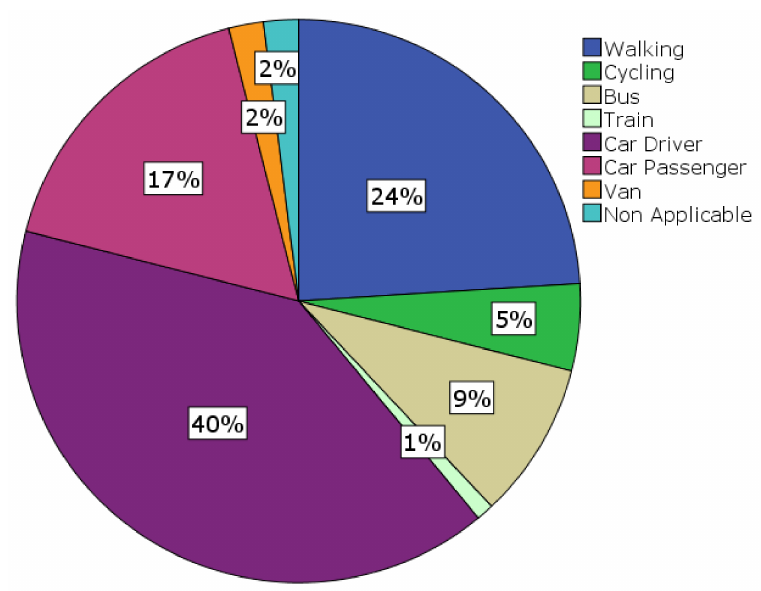
Figure 1. How people living in Galway travel to work [46].